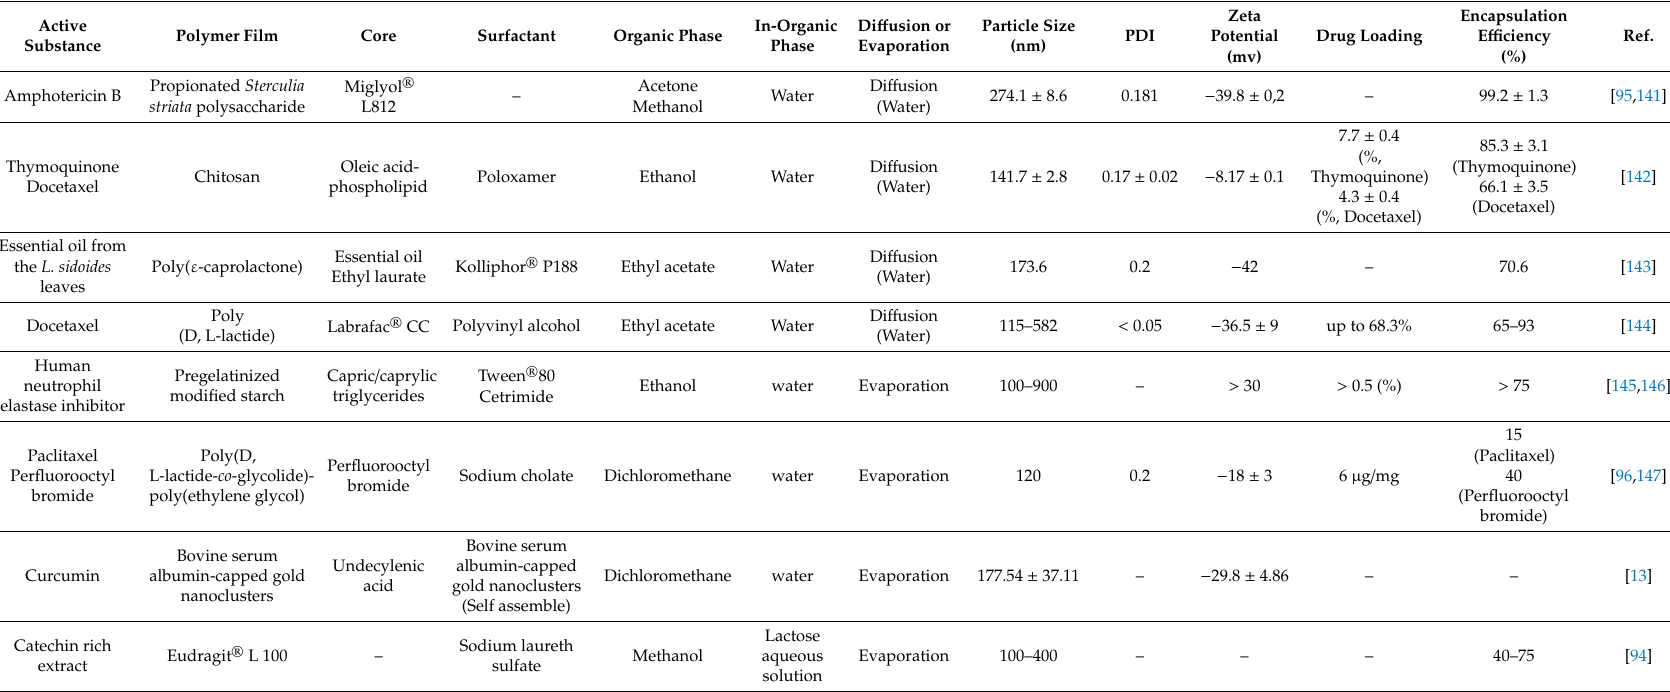
Table 2. Examples of polymeric nanocapsule formulation by emulsion–di ff usion / evaporation method in recent five